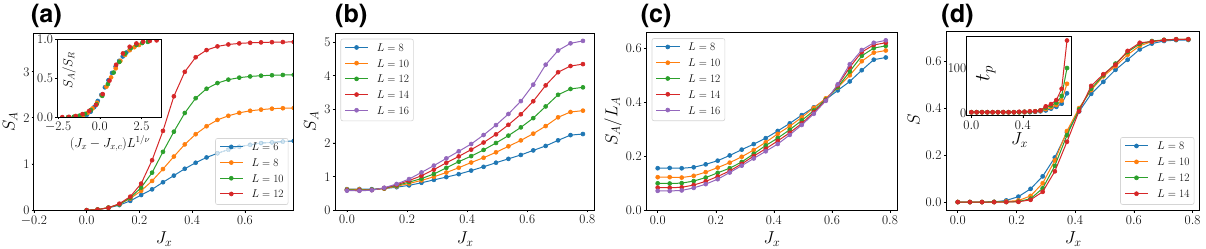
FIG. 5. (a) Half-chain entanglement entropy averaged over all eigenstates and 200 random realizations of the Floquet unitary U F defined in Eq. (9). The inset presents the data collapse based on the scaling ansatz: S A / S R = F [ ( J x − J x , c ) L 1 /ν ] with ( J x , c , ν) = = 0.5 ( L log 2 − 1 ) being the entanglement entropy of a random pure state. (b) Entanglement entropy of long- ( 0.23, 1.09 ) and S R time-evolved states averaged over 150 random realizations of the spacetime-rotated nonunitary circuit [Eq. (10)]. (c) Entanglement entropy density of the same circuit as in (b). (d) The entanglement entropy of an ancilla qubit that is initially prepared in the maximally entangled state with the system, and then evolved for time t ∼ L with the nonunitary circuit in Eq. (10). Averaging is done over 2000 realizations of the disorder. Inset: time scale t p that measures the persistence of the entanglement of the ancilla